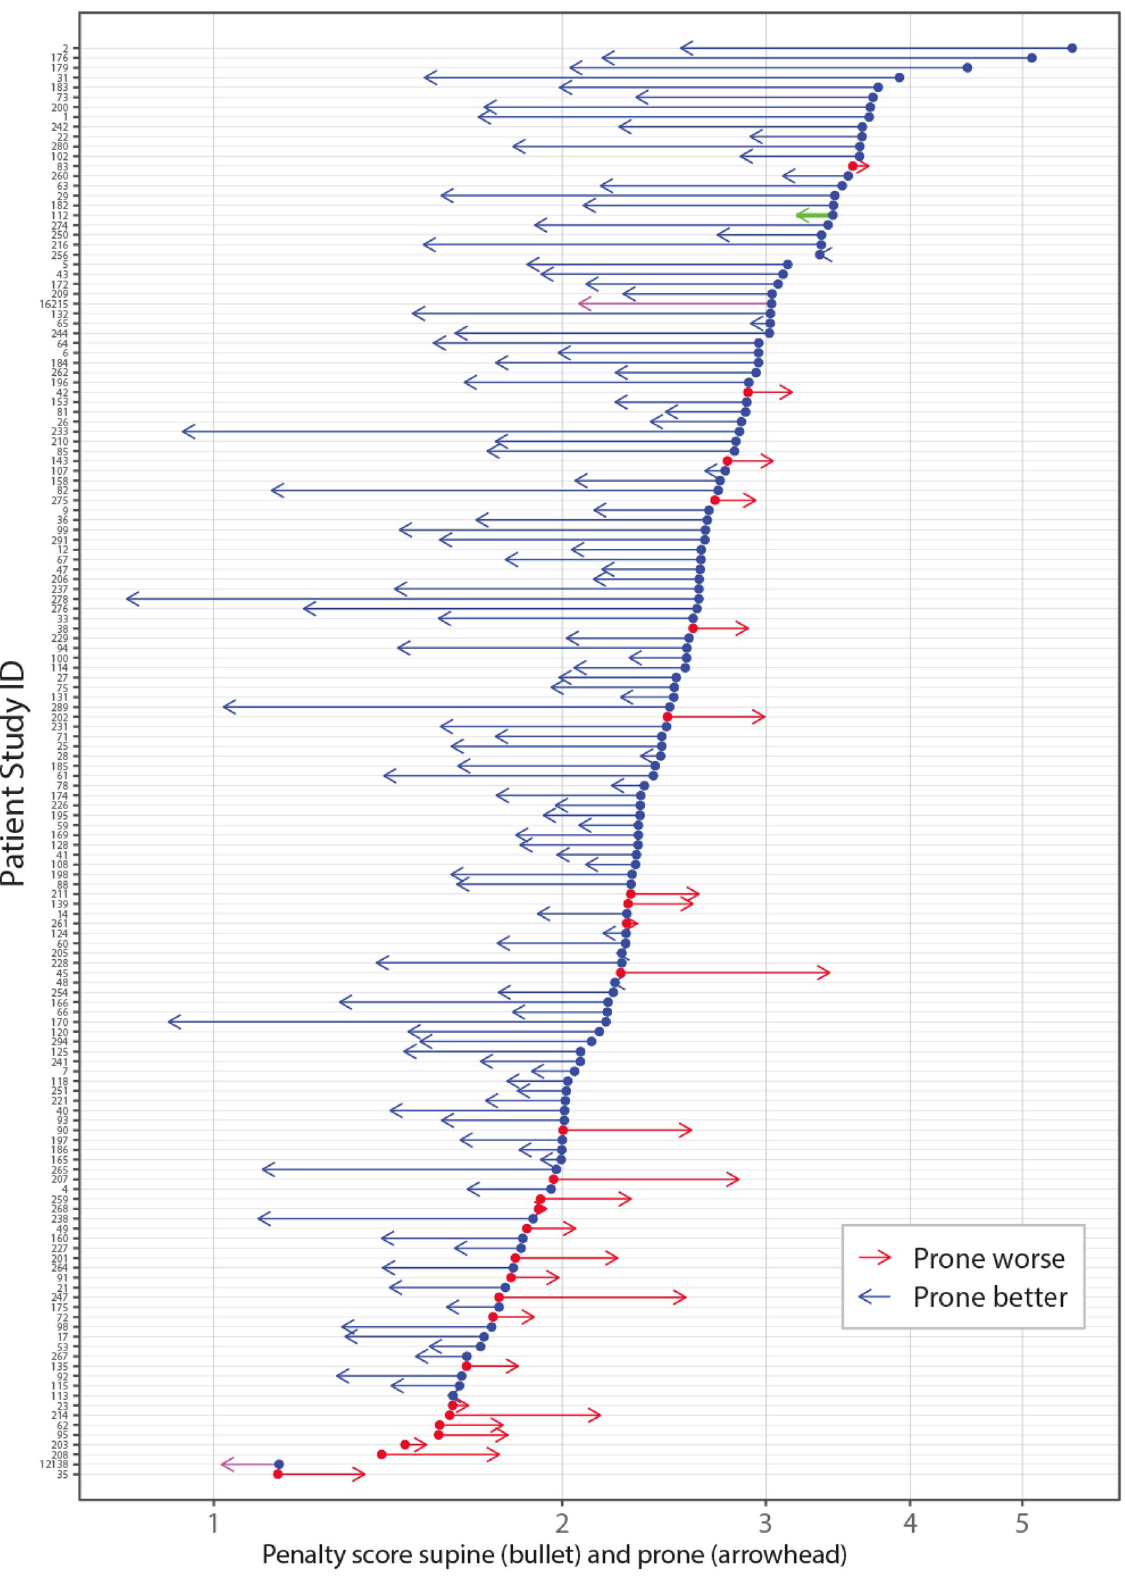
Figure 3. Change of individual patients’ penalty score from supine to prone. Bullet, penalty supine. Arrowhead, penalty prone. Arrow right, prone increases penalty; arrow left, prone decreases penalty. Green, breast implant; purple, bilateral